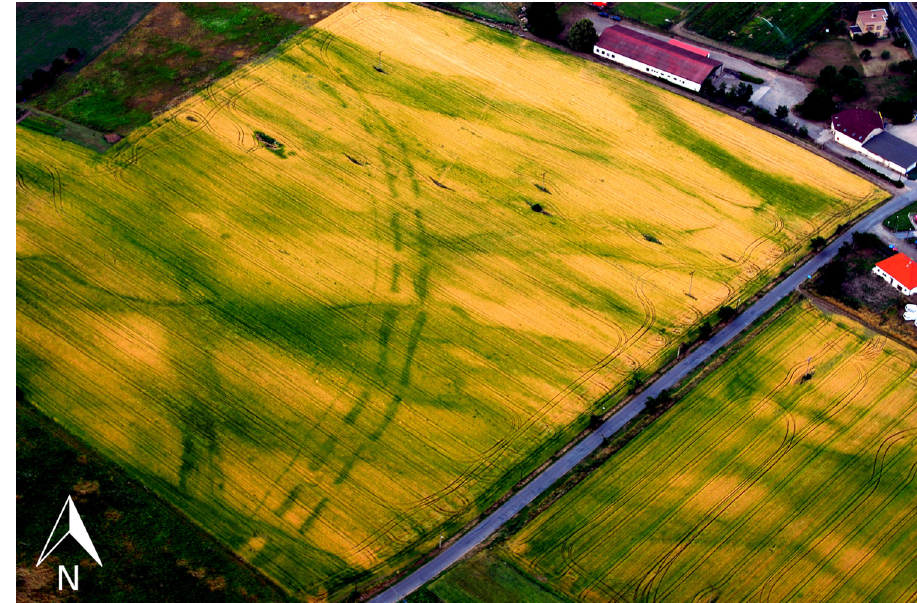
Figure 5: Kly ( M ě lník district ) . A Michelsberg culture causewayed enclosure. Cropmarks showing two lines of parallel ditches and the inner palisade ( photograph by M. Gojda )